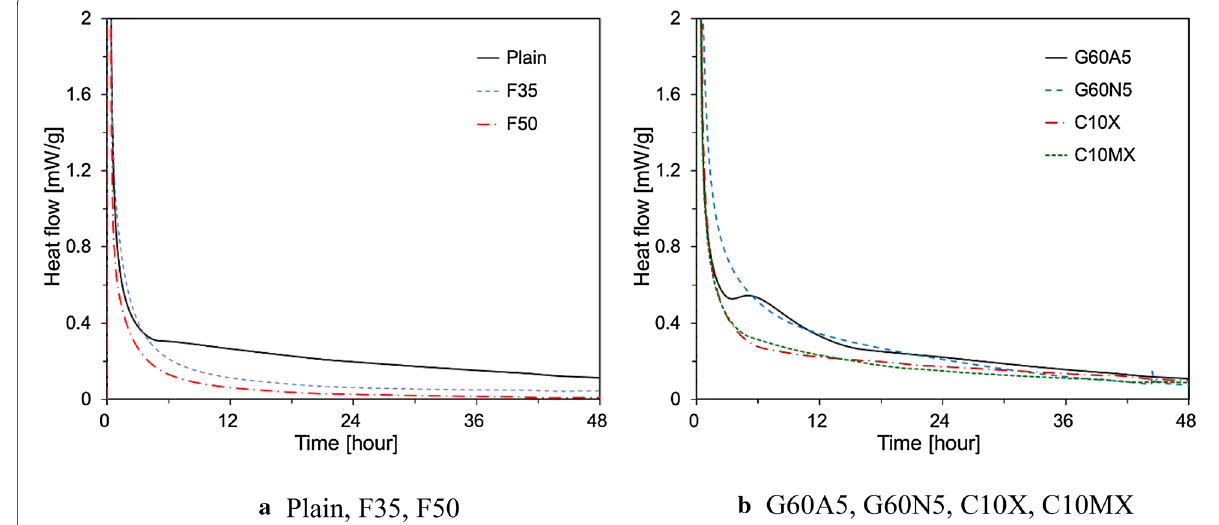
Fig. 8 Heat flow rate after 91 days of